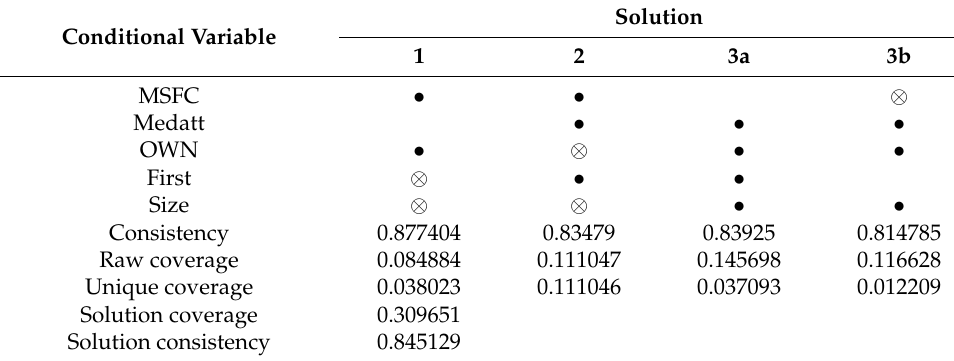
Table 7. Configuration for obtaining food safety certification (consistency: